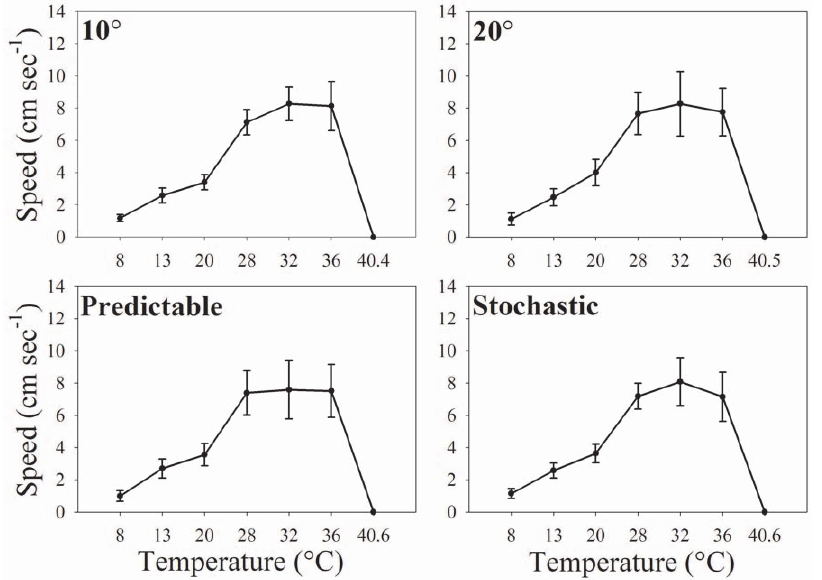
Figure 2. Performance curves were similar among isopod exposed to different thermal treatments. Labels for thermal treatments correspond to those used in Figure 1. No significant differences were observed among thermal optima or performance breadths for the four treatment groups (see Table 2). Error bars represent 95% confidence intervals.